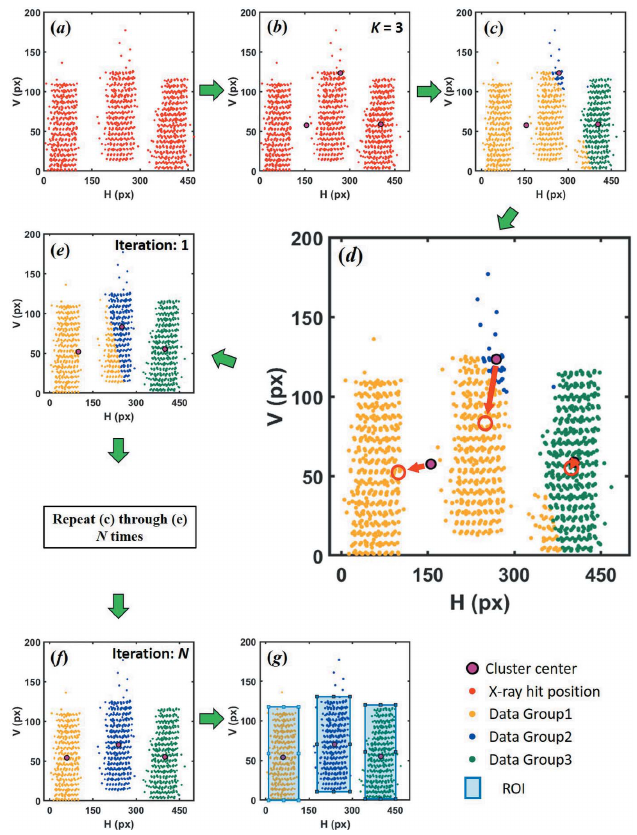
Figure 3 Workflow of automatic ROIs setting (automatic determination of ROIs). ( a ) Three clusters of merged X-rays hit positions with 17 linear distributions in one module of the 2D-PSD. The points have been reduced by 10 times to distinctly show the distribution. ( b ) Initially assigned three arbitrary centers of the clusters (black circles). ( c ) X-ray hit positions surrounding the cluster centers. ( d ) Reassigned locations of the three cluster centers. ( e ) Data clusters reassigned to new cluster centers. ( f ) Clusters and cluster centers are finally determined. ( g ) Three ROIs are automatically determined based on the clusters and their centers.